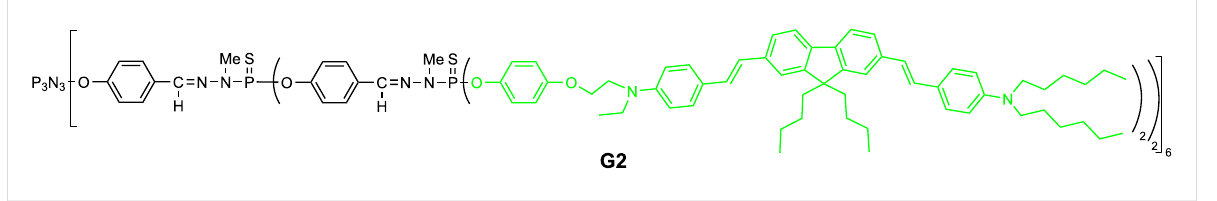
Figure 3: Linear structure of the generation 2 dendrimer bearing 24 green-emitting TPA fluorophores on the surface.